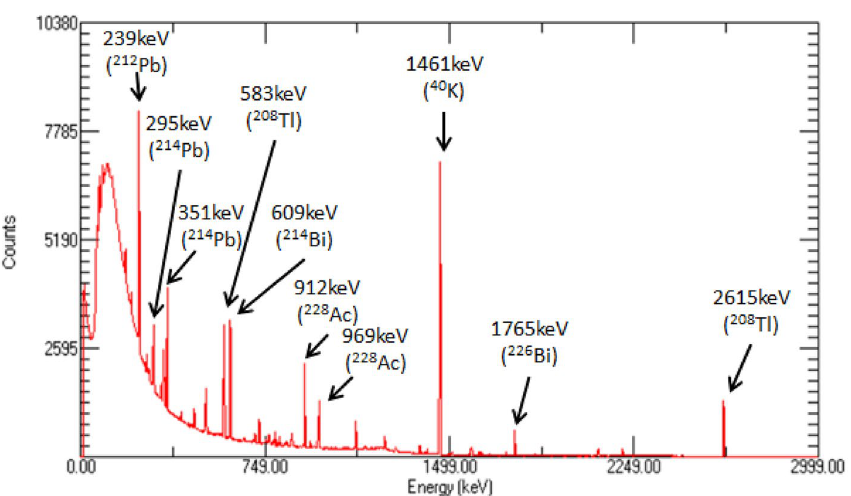
Figure 5. Background energy spectrum obtained from outdoor measurement at 15000 s. The characteristic γ-rays of various natural radioactive backgrounds are marked with